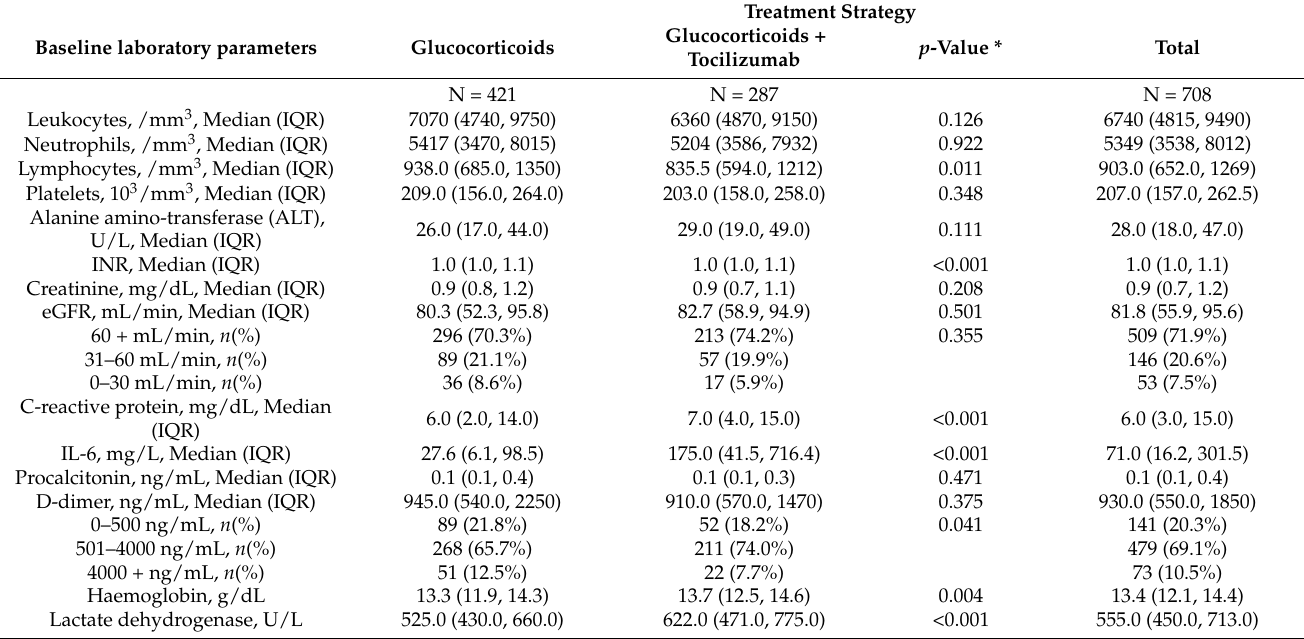
Table 3. Laboratory parameters by treatment group at